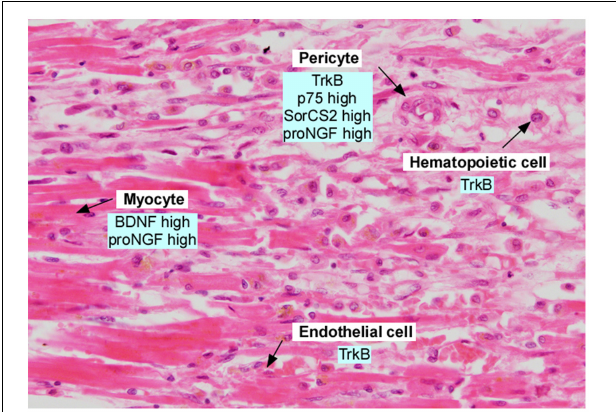
FIGURE 3 | Section of adult human myocardium following myocardial infarction, in the border zone. Section was stained with hematoxylin and eosin and annotated with expression of neurotrophins and neurotrophin receptors. Data was derived from Kermani et al. (2005), Liu et al. (2006), Cai et al. (2006), Okada et al. (2010), Cao et al. (2012), Siao et al. (2012), and Halade et al. (2013).